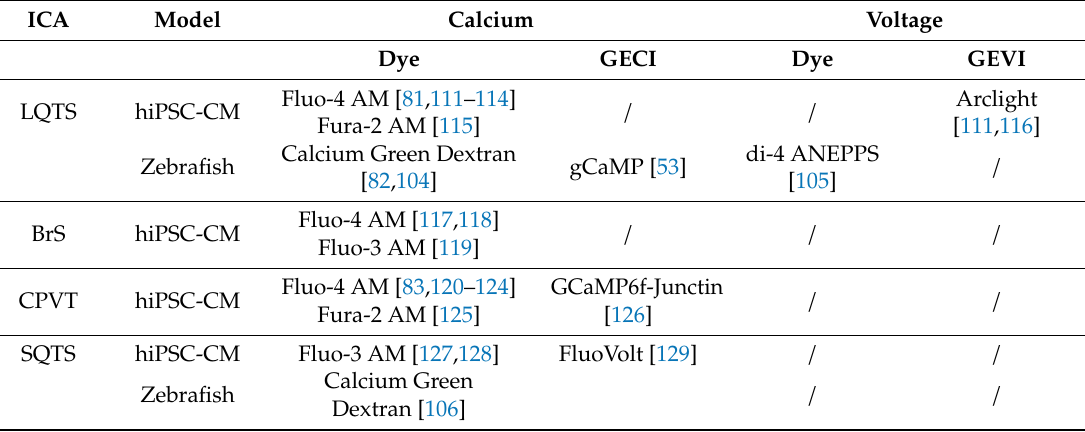
Overview of optical mapping methods used to study ICAs in hiPSC-CMs and zebrafish. Inherited cardiac arrhythmias (ICA), long QT syndrome (LQTS), Brugada syndrome (BrS), catecholaminergic polymorphic ventricular tachycardia (CPVT), short QT syndrome (SQTS), genetically encoded calcium indicator (GECI), genetically encoded voltage indicator